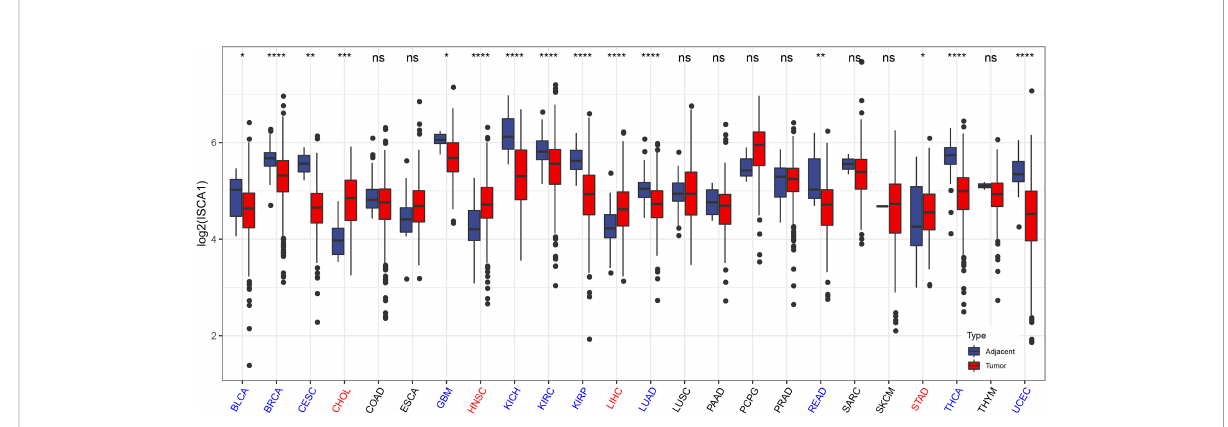
FIGURE 2 The expression of the ISCA1 gene in pan-cancer is varied from that in adjacent cancer. Blue represents signi fi cantly low expression in tumor, and red represents signi fi cantly high expression in tumor (* represents p < 0.05, ** represents p < 0.01, *** represents p < 0.001, **** represents p < 0.0001, ns represents p >